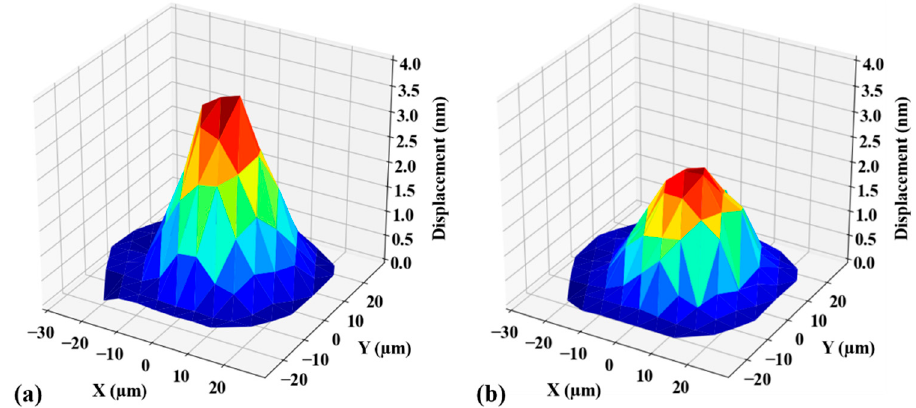
Figure 5. The first resonance mode of the devices working under water load for ( a ) a control group without PDMS backing (C-PMUT) and ( b ) B-PMUT. (C-PMUT) and ( b )